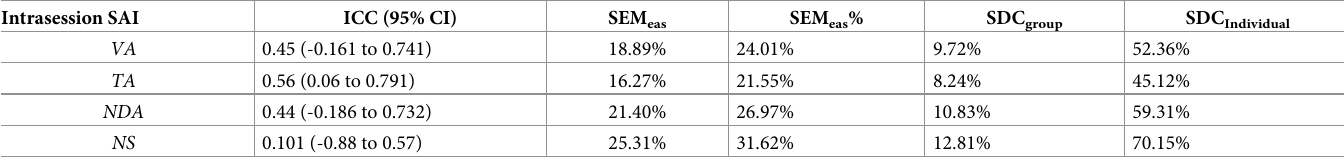
Table 2. Intrasession reliability statistics SAI. SEM eas , SDC individual, SDC group are expressed as a percentage of the unconditioned MEP. In contrast, %SEM eas is expresses the SEM eas as a percentage of the